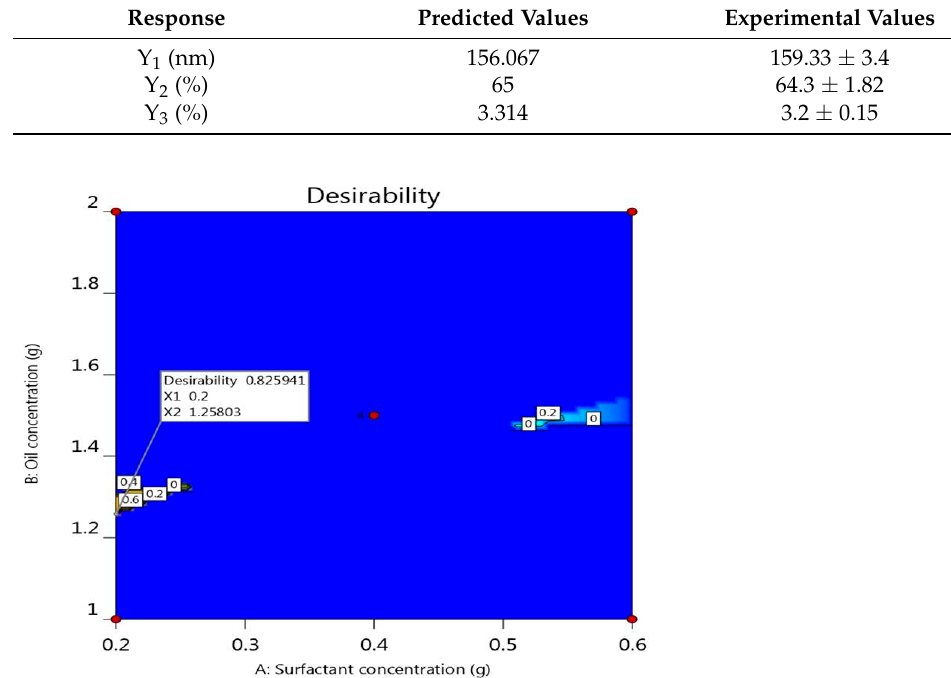
Figure 6. Optimization figure screening the influence of surfactant concentration and oil concen ‐ tration on overall desirability.